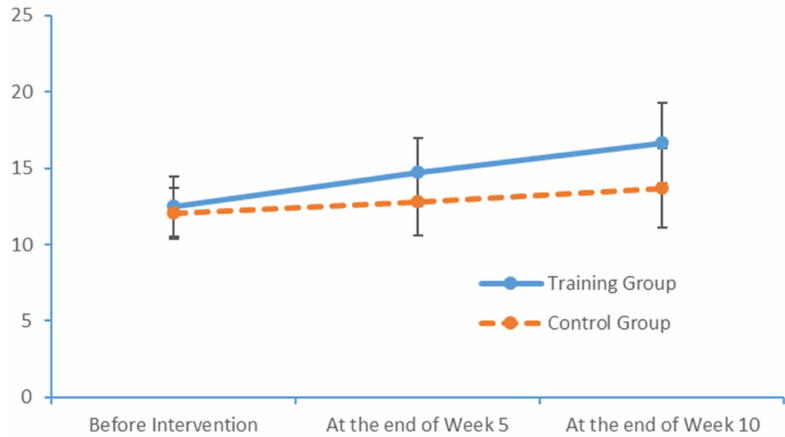
Figure 5. Changes in the left-hand PPT scores of the two groups at each time point.